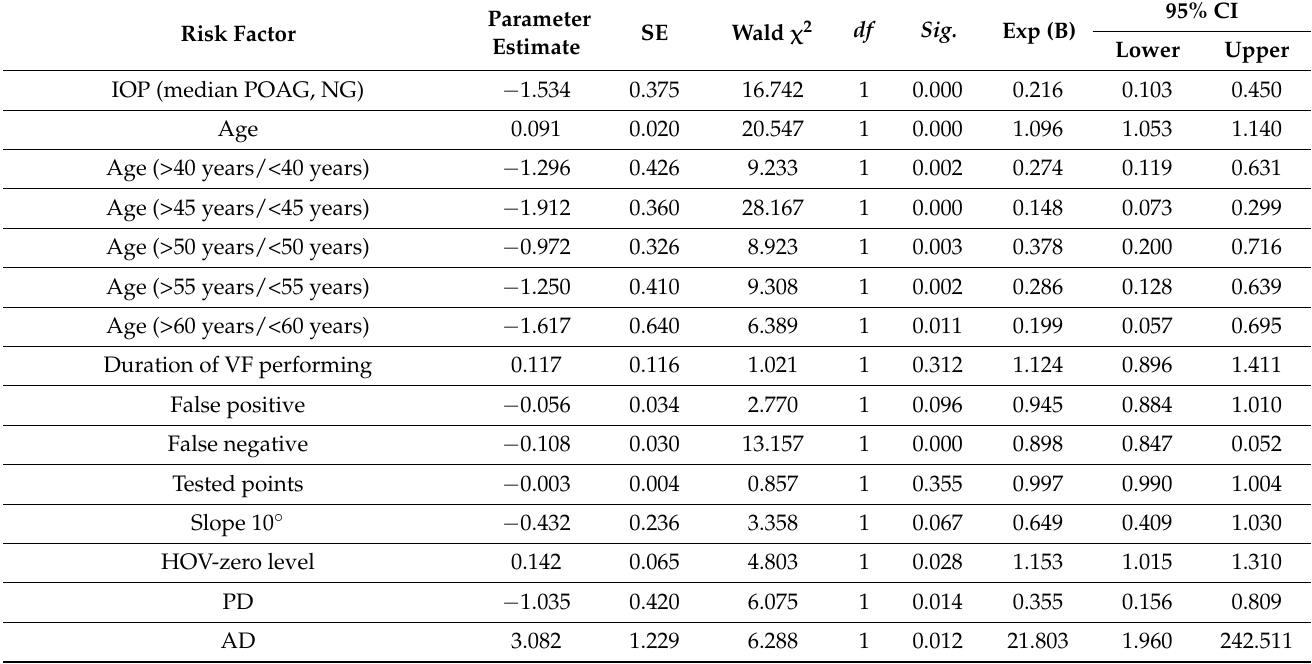
Table 8. Distribution of binomial logistic analysis results for POAG and NG patients at the first